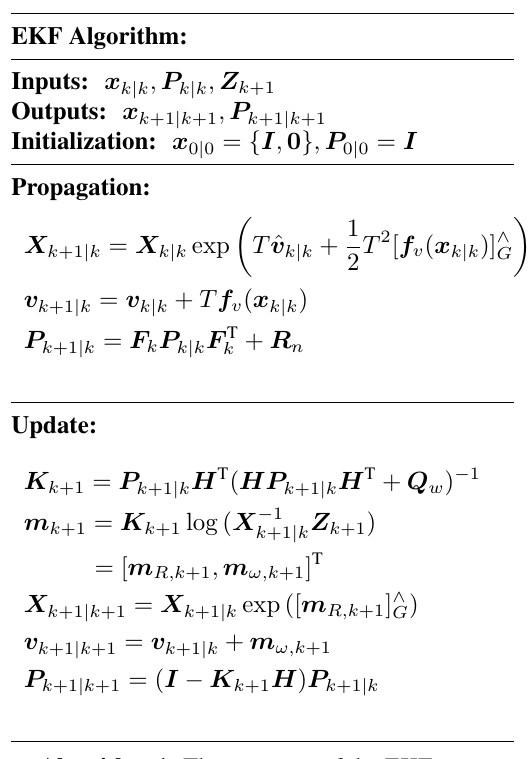
Algorithm 1: The structure of the